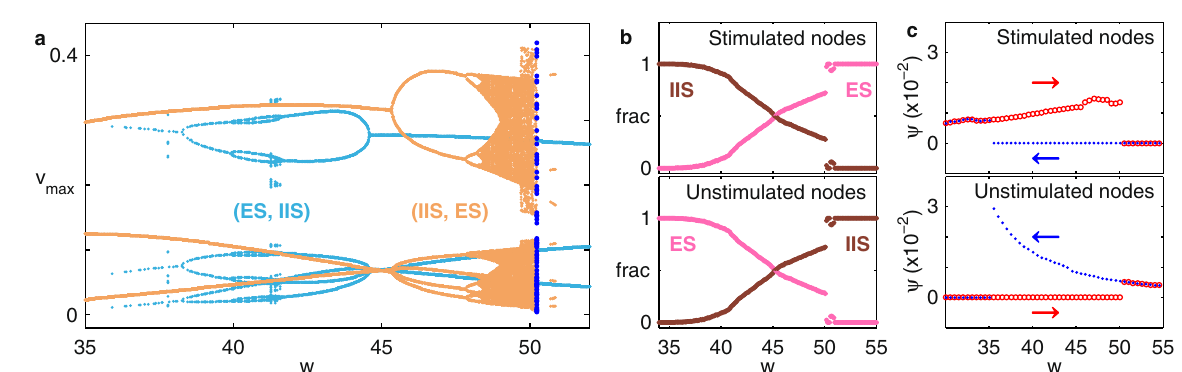
Figure 4. Symmetry exchange transition in a system of N = 4 globally coupled oscillators with N stim = 2. ( a ) Bifurcation diagram showing the peaks ( v m ax ) of the inhibitory components of all nodes as w is varied. Distinct coexisting attractors corresponding to (IIS, ES) and (ES, IIS) are indicated by orange and light blue, respectively. ( b,c ) Variation of the ( b ) fractional basin size of these attractors and ( c ) the order parameter ψ = 〈 σ i 2 ( v i ) 〉 with w , shown separately for the (top) stimulated and (bottom) unstimulated groups. The distinct trends seen in ( c ) on increasing (red circle) or decreasing (blue dots) w indicate the occurrence of hysteresis-like